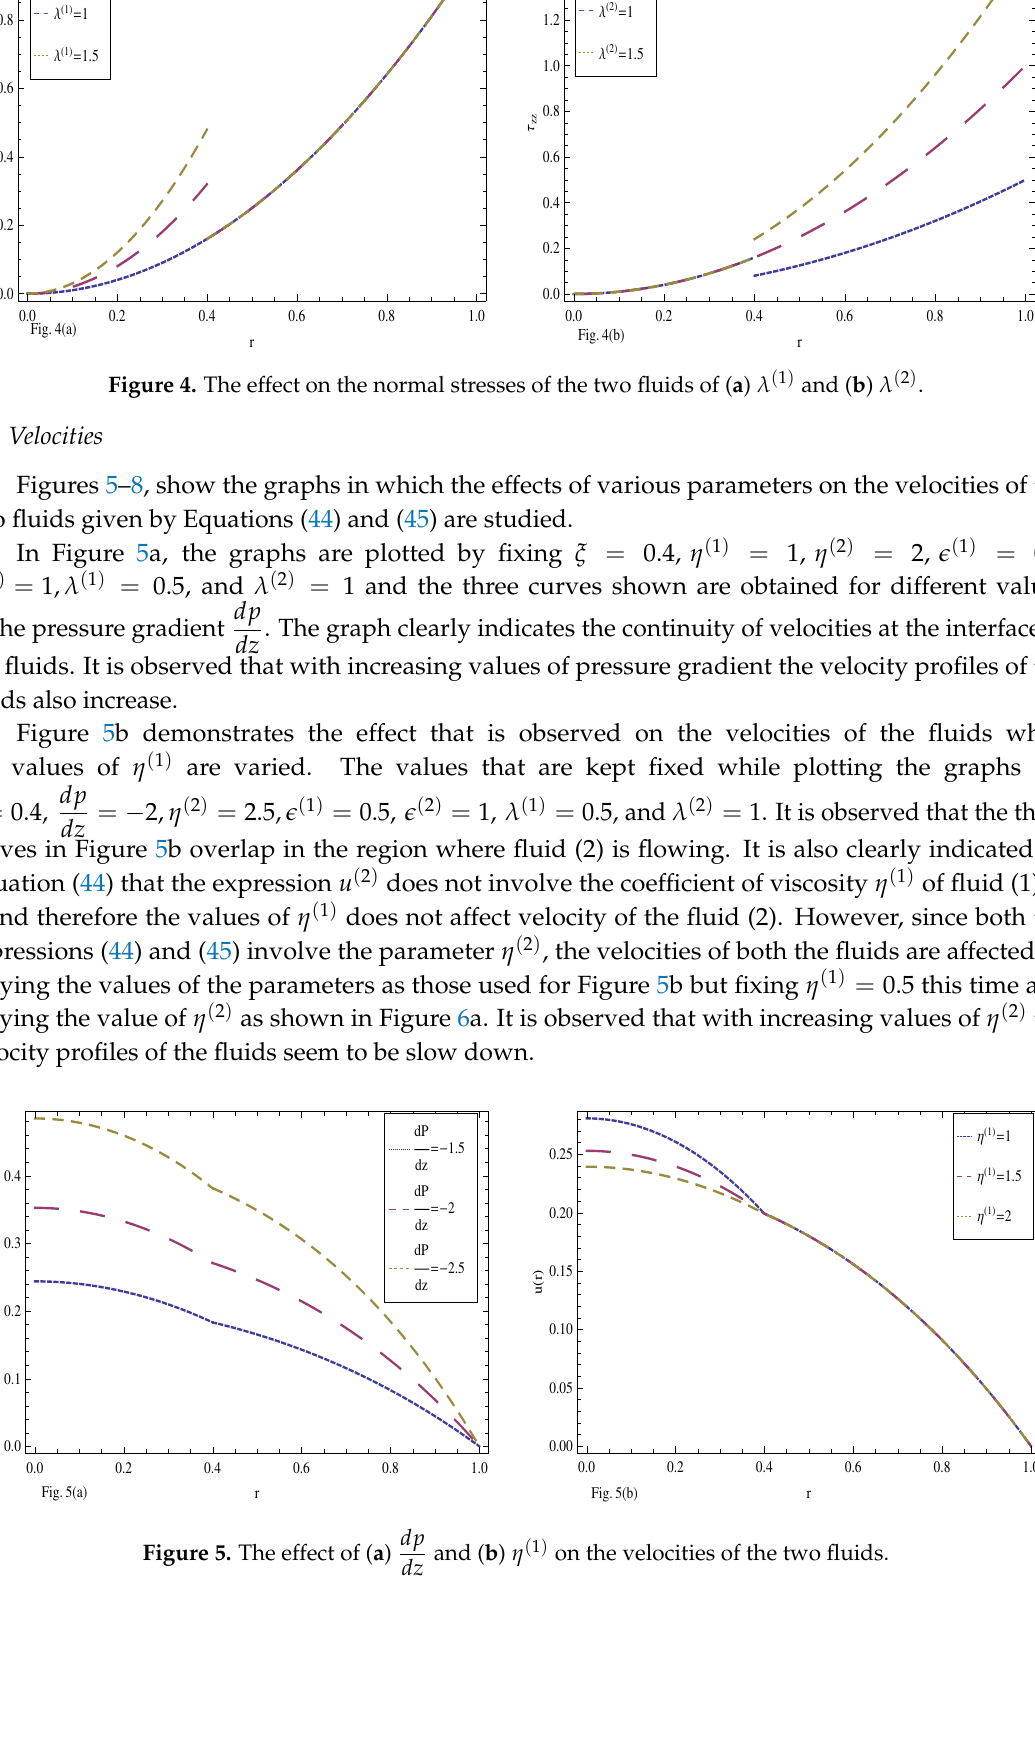
dp and ( b ) η ( 1 ) on the velocities of the two dz